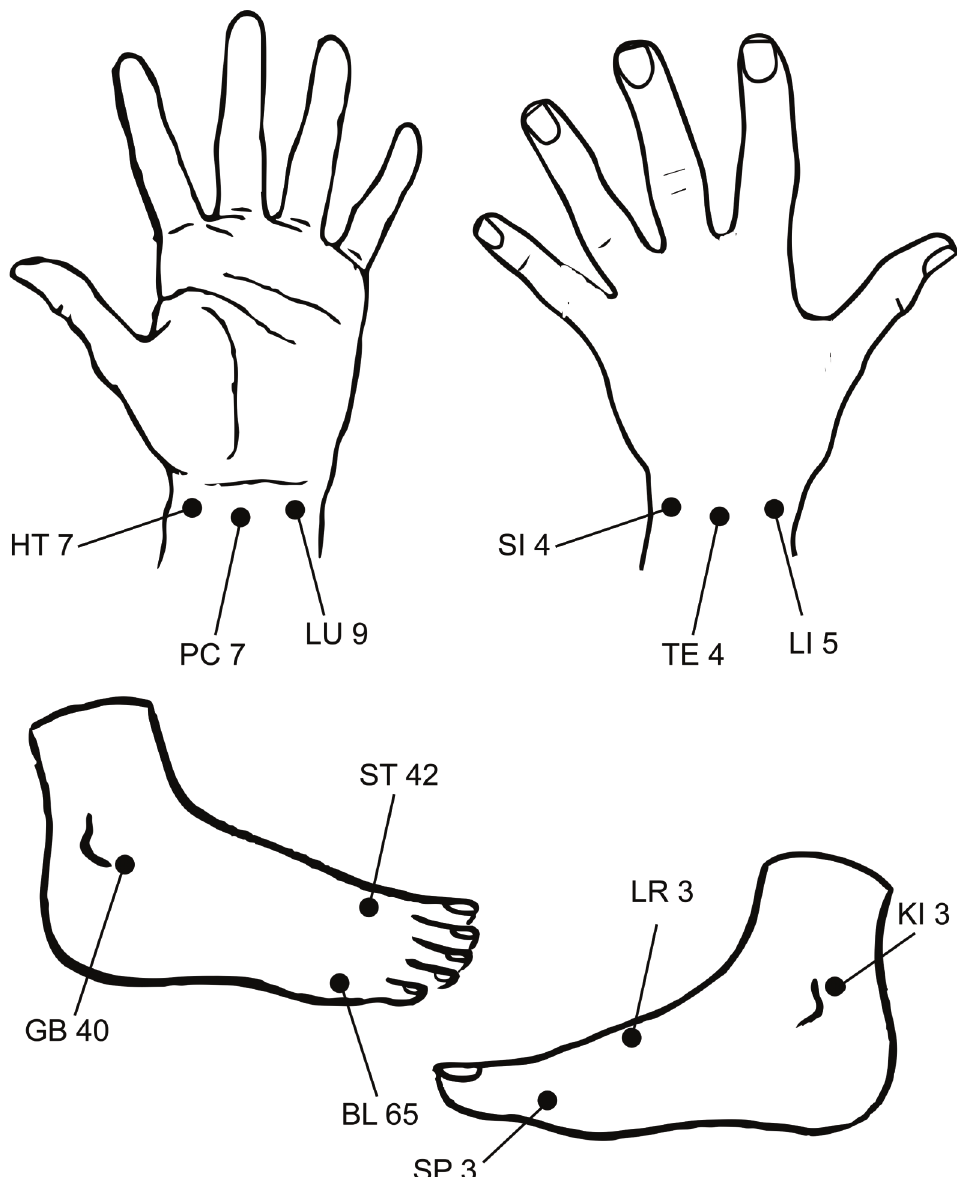
Figure 2 - The 24 MEAD measuring points on the hands and feet according to traditional Chinese medicine theory. (LU: Lung; PC Pericardium; HT: Heart; SI: Small Intestine; TE: Triple Energizer; LI: Large Intestine; SP: Spleen; LR: Liver; KI: Kidney; BL: Urinary Bladder; GB: gallbladder; ST: